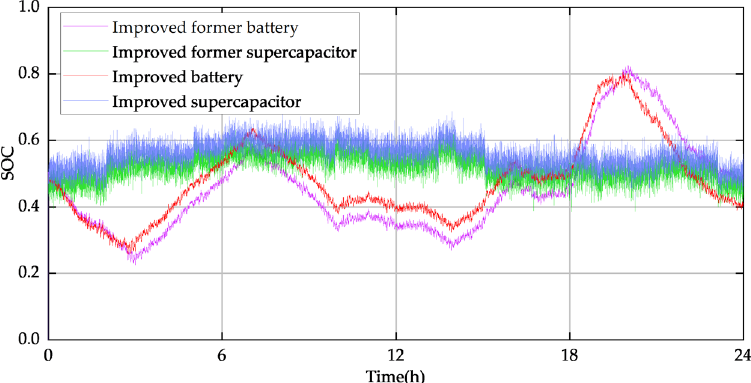
Figure 14. Comparison of the charge states of HESS before and after the improvement.